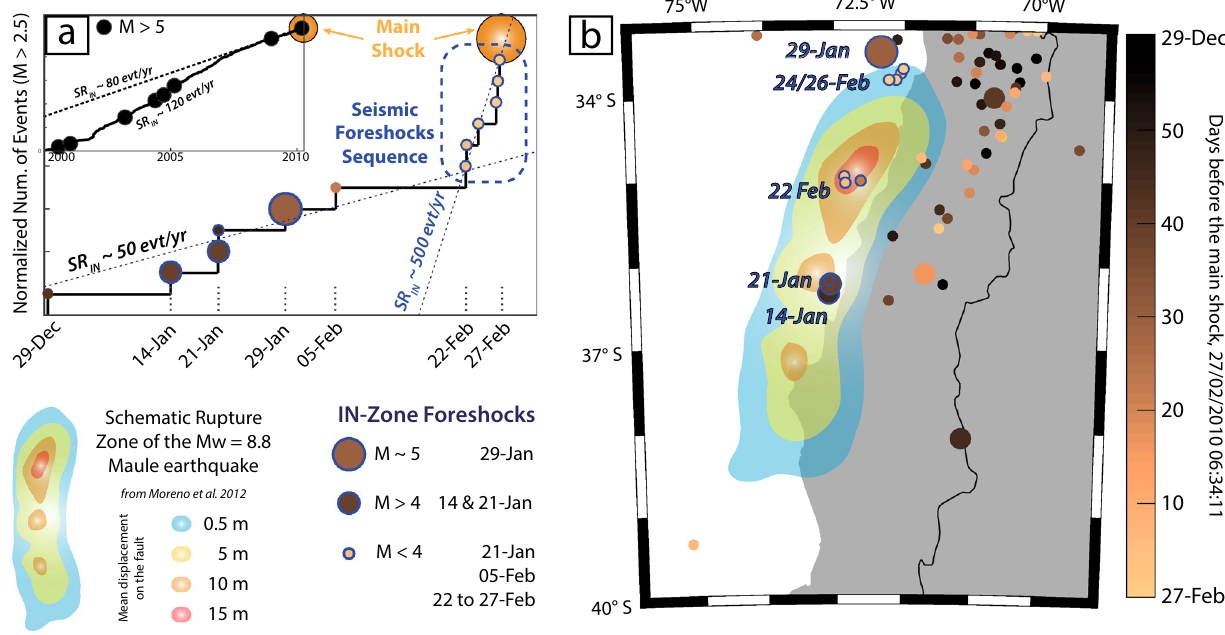
Figure 5. Early change of the seismic rate before the M W 8.8 Maule main shock. ( a ) Normalized number of events within the rupture zone (IN-zone). The upper left-corner plot shows the long time-scale seismic activity as a function of time. ( b ) Distribution of the recorded events in the last 2 months before the main shock. Red and orange areas correspond to the largest co-seismic slip (10–16 m, from Moreno et al . 36 finite fault model). The marker face colors indicate the time of occurrence of the events in days before the main